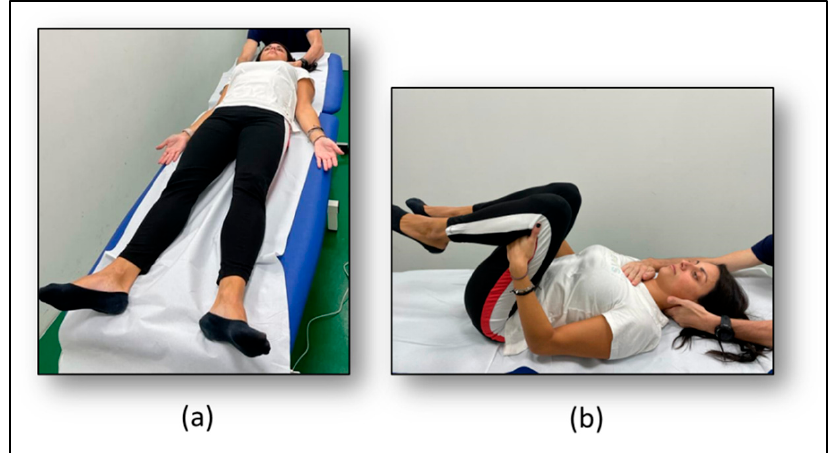
Figure 2. Postural rehabilitation intervention exercises. (a) Postural rehabilitation first posture; (b) Postural rehabilitation second posture.